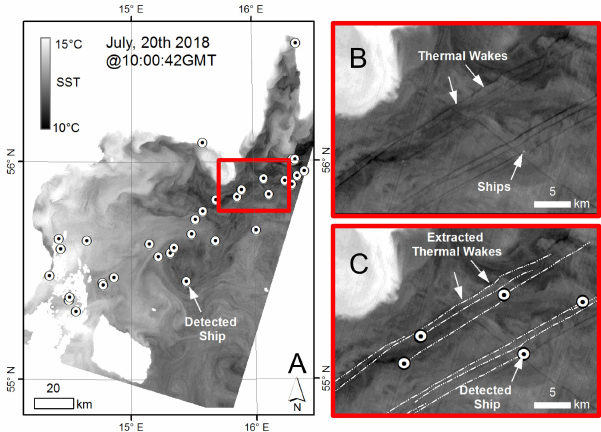
Figure 4. Example of satellite scene with visible thermal wakes in the Bornholm study area, with an illustration of the thermal wake detection process. Panel (a) is the original satellite scene with the detected ships marked as white circles with black dots. The red box marks the zoomed-in area in (b) and (c) . In (b) , the thermal wakes are visible as darker lines and the ships as small white dots. Panel (c) shows the detected ships and extracted thermal wakes. Landsat-8 image courtesy of the US Geological